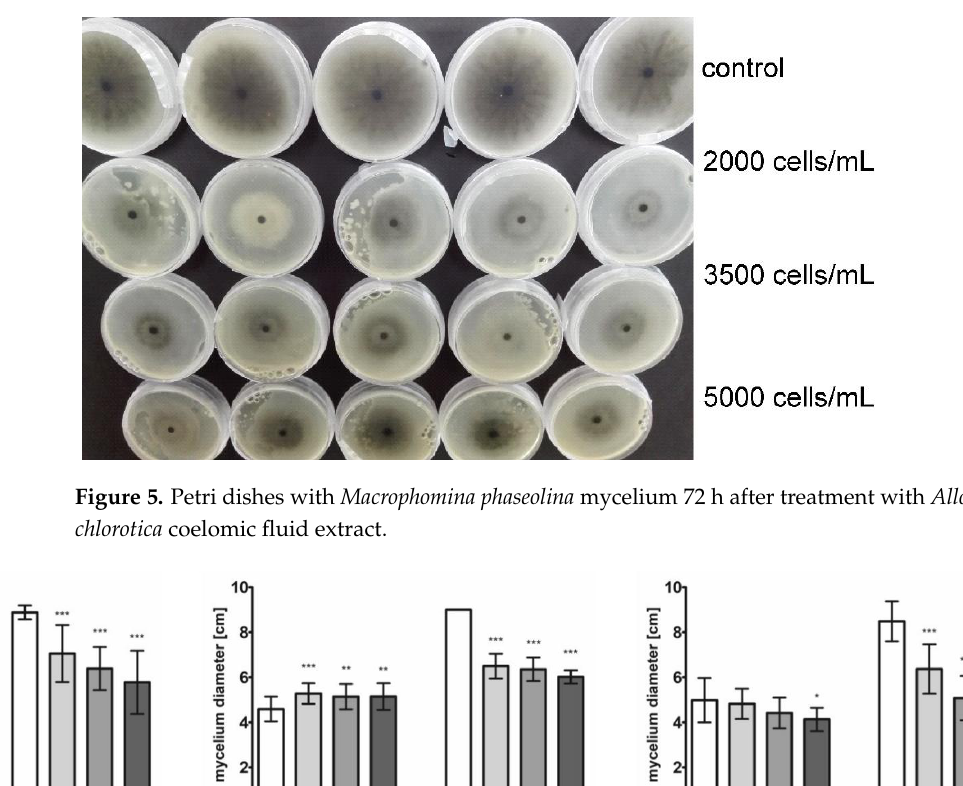
Figure 4. Growth (mean diameter ± SD) of Macrophomina phaseolina mycelium 24, 48 and 72 h after treatment with Eisenia andrei , Dendrobaena veneta and Allolobophora chlorotica coelomic fluid extracts. Significant differences between control and groups treated with coelomocyte extracts are labeled with * ( p < 0.05), ** ( p < 0.01) and *** ( p < 0.001).